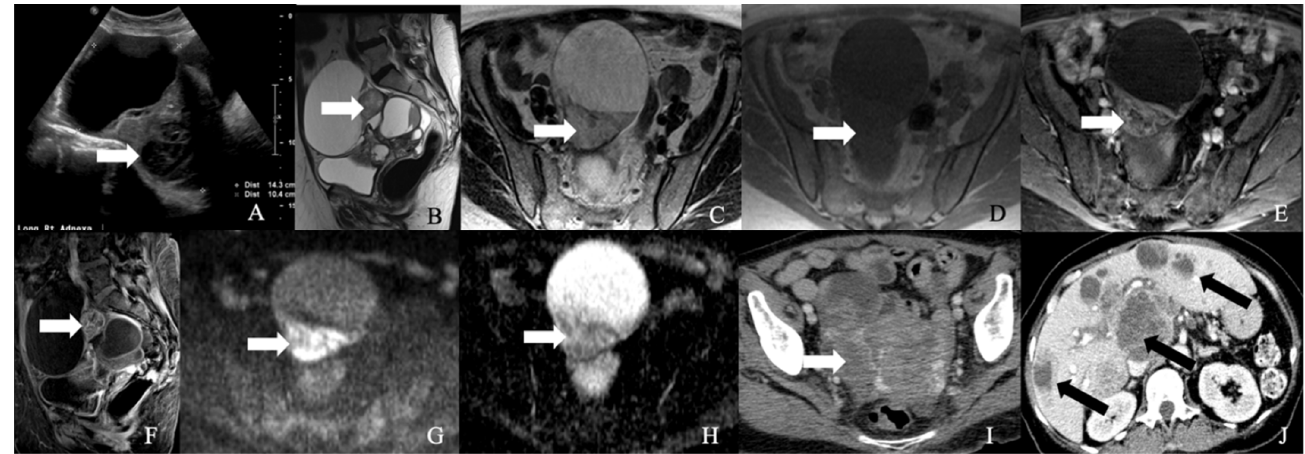
Figure 7. 52-year-old female with a neuroendocrine tumor of the ovary. ( A ) Transverse ultrasound image of the pelvis demonstrates a heterogeneous mass in the pelvis (arrow) measuring about 14 cm. ( B ) Sagittal T2 weighted image, ( C ) axial T2 weighted image, ( D ) axial pre-contrast T1 weighted image, ( E ) axial fat-saturated post-contrast T1 weighted image, ( F ) sagittal fat-saturated post-contrast T1 weighted image, ( G ) axial diffusion-weighted images (B-100), ( H ) axial apparent diffusion coefficient images demonstrate a multiloculated mass with enhancing nodule (arrow) and restricted diffusion, ( I ) axial post-contrast CT image of the pelvis shows the heterogenous mass (arrow), and ( J ) axial post-contrast CT image of the abdomen demonstrates the multiple hepatic metastases (arrow).